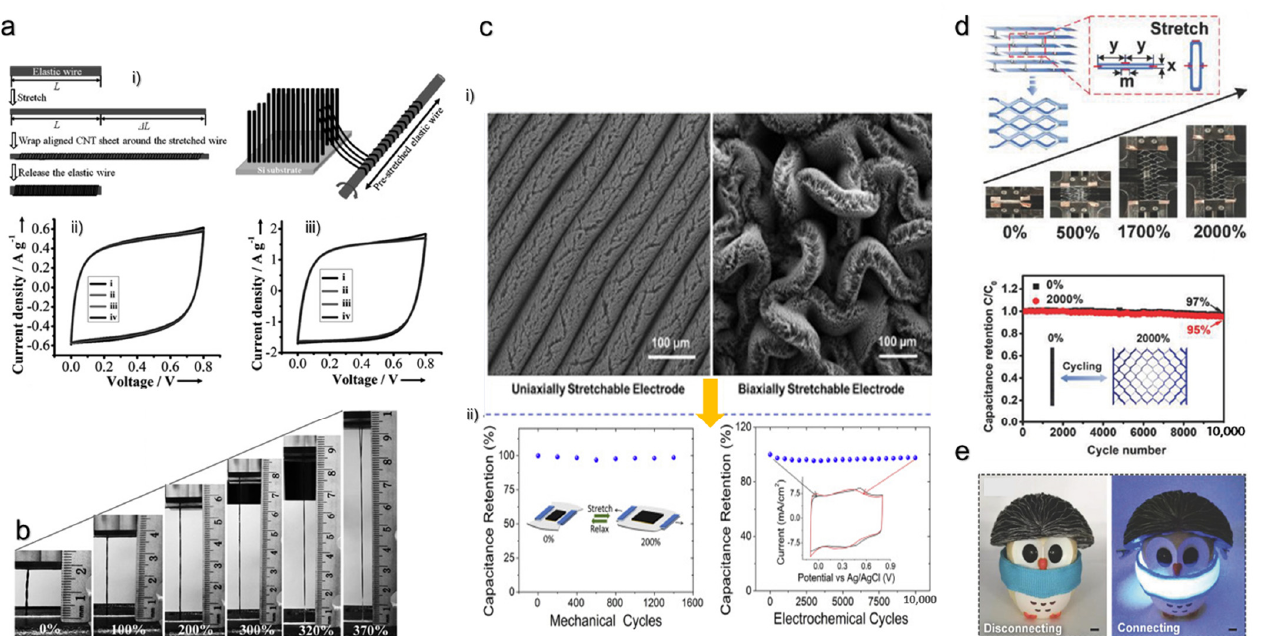
Figure 13. Supercapacitors for powering bioelectronic devices. ( a ) (i) Schematic illustration of fabri- cating stretchable conducting wire by wrapping an aligned CNT sheet around a pre-stretched elastic wire. CV curves of the supercapacitors based on (ii) the bare CNT-wrapped and (iii) CNT/PEDOT- PSS-wrapped wires [160]. ( b ) Digital photograph of a typical wire-shaped supercapacitor with a twisted structure after being stretched from strains of 0 to 370% [160]. Reprinted with permission from Ref. [160]. Copyright 2015 Wiley-VCH Verlag GmbH & Co. ( c ). Stretchable Au-CNT forest electrodes: (i) SEM image of the Au-CNT forest pattern morphology generated by a uniaxial pre- strain of 300% and by applying a biaxial pre-strain of 200% × 200%. (ii) Capacitance retention of a uniaxially stretchable Au-CNT forest electrode under mechanical stretching–relaxation cyclic defor- mations to a strain of 200% and for 10,000 charge/discharge cycles at the relaxed state. Inset shows the CV curves measured before and after the electrochemical stability test at the scan rate of 500 mV s − 1 [159]. Reprinted with permission from Ref. [159]. Copyright 2020 Elsevier Inc. ( d ). Digital images of stretchable rectangular-shaped supercapacitors (with geometric parameters of y = 0.7 cm, m = 0.2 cm, x = 194 µm, T = 0.5 cm) under different strain tests. The inset images (upper left) are the scheme showing the expandable honeycomb structure and the hexagonal unit cell before and after being stretched. Capacitance retention ratio of 3D stretchable supercapacitor based on PPy/BPO-CNT elec- trodes tested at 7.8 mA cm − 2 under the cycling tensile strain of 2000% [161]. ( e ). Arched bridge- shaped supercapacitors acting as a 3D helmet worn on the head of an owl toy model to power a 3.0 V flexible LED strip (right) [161]. Reprinted with permission from Ref. [161]. Copyright 2018 Wiley- VCH Verlag GmbH & Co.